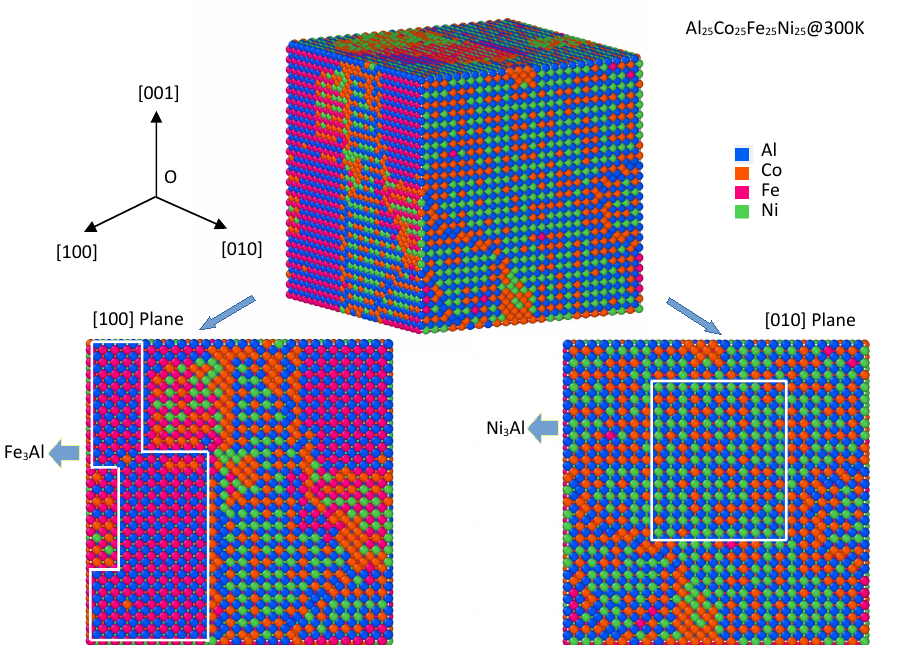
Figure 4. Atomic configuration of AlCoFeNi HEAs at 300 K. . The [100] and [010] crystal planes of the three-dimension AlCoFeNi HEAs are also shown at the bottom. Here Al, Co, Fe, and Ni atoms are indicated with blue, orange, purple, and green spheres, respectively. The L1 2 -type precipitates are also framed in the